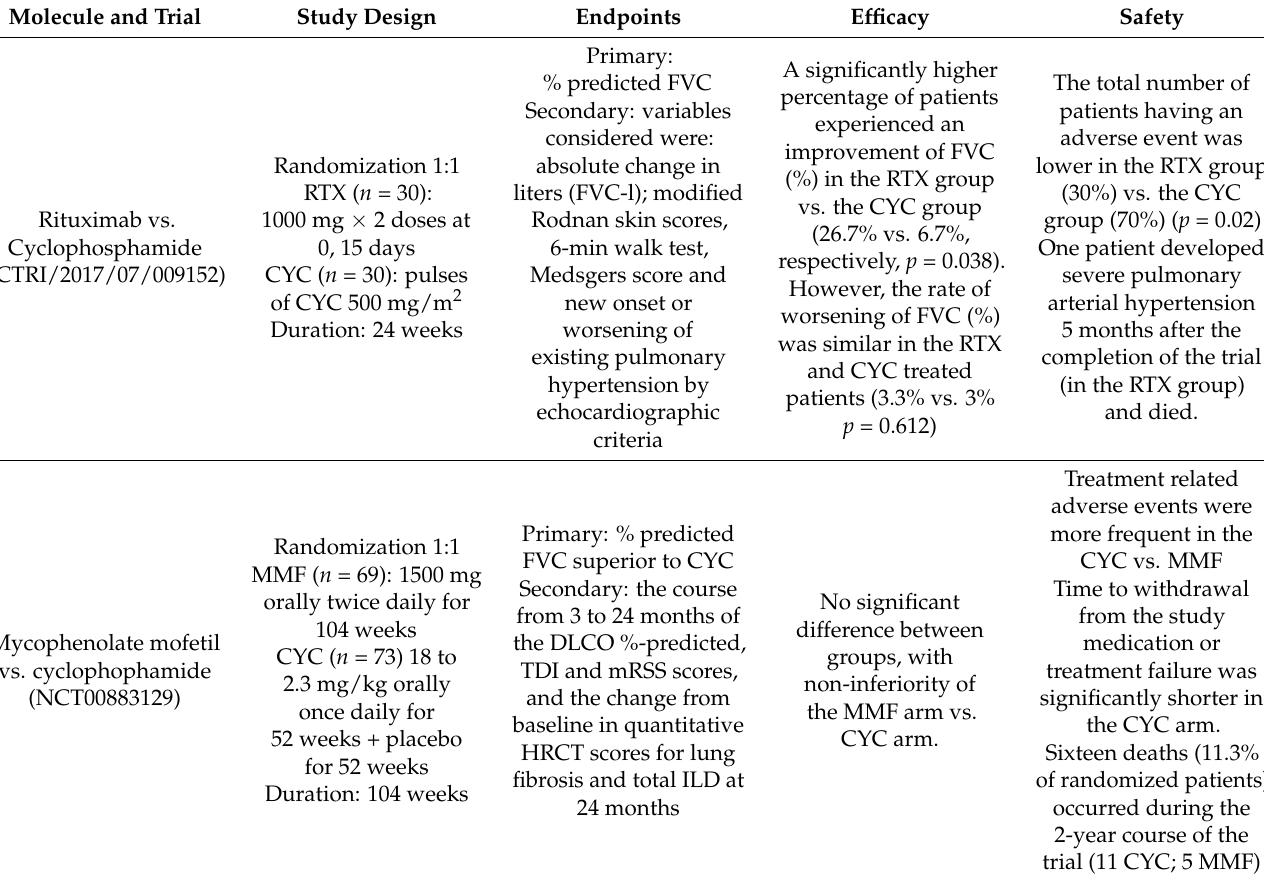
Table 3. Head-to-head randomized double-blind clinical trials in SSc-ILD. Molecule and Trial Study Design Endpoints